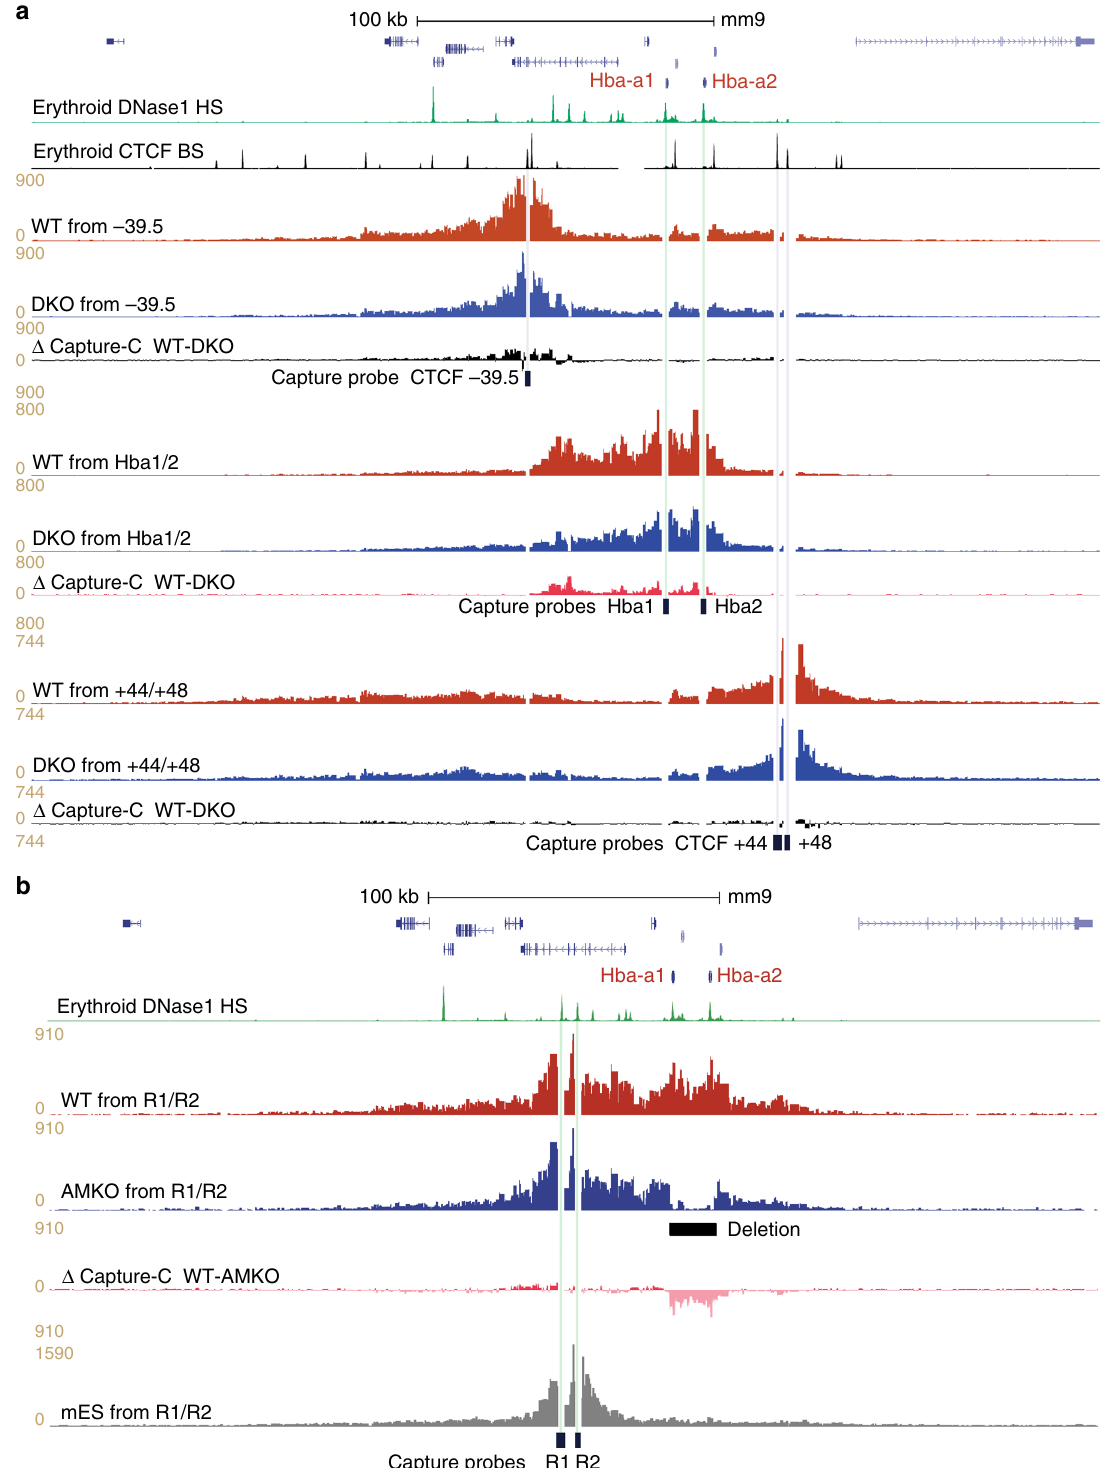
Fig. 7 The α -globin domain still forms in the absence of elements critical for α -globin expression. a Gene map with DNase1 HS (green) and CTCF BS (black) genome browser tracks, followed by NG Capture-C tracks highlighting interactions from CTCF BS − 39.5, Hba1/2 and CTCF BS + 44/48 viewpoints in 30 h MFL WT (red) and MFL DKO (homozygous deletions for MCS-R1/R2) (blue), with differential tracks ( Δ ) showing persistence of domain structure when viewed from CTCF sites even though interaction frequencies internal to the domain are affected. b Gene map with DNase1 HS (green) followed by NG Capture-C tracks highlighting interactions from MCS-R1/R2 viewpoint in MFL WT (red) and MFL AMKO (blue), with a differential track ( Δ ) showing persistence of domain structure in AMKO when contrasted with the absence of a domain observed in mES cells